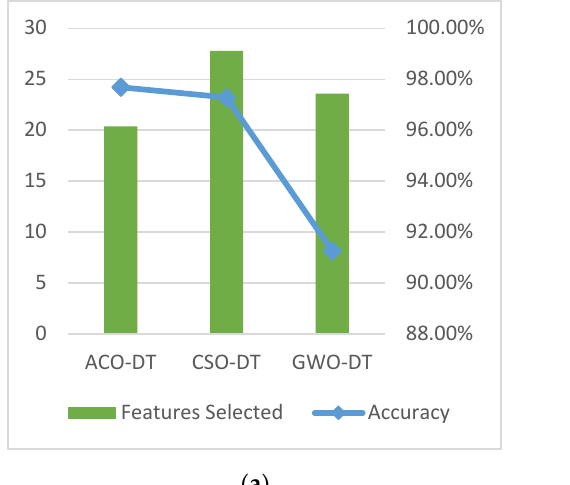
racy with the SOMLAP dataset. with the SOMLAP